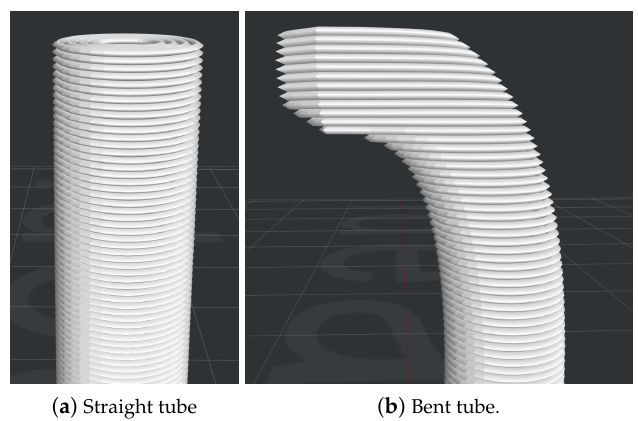
Figure 5. Influence of curvature on the printed layers of a pressure tap.